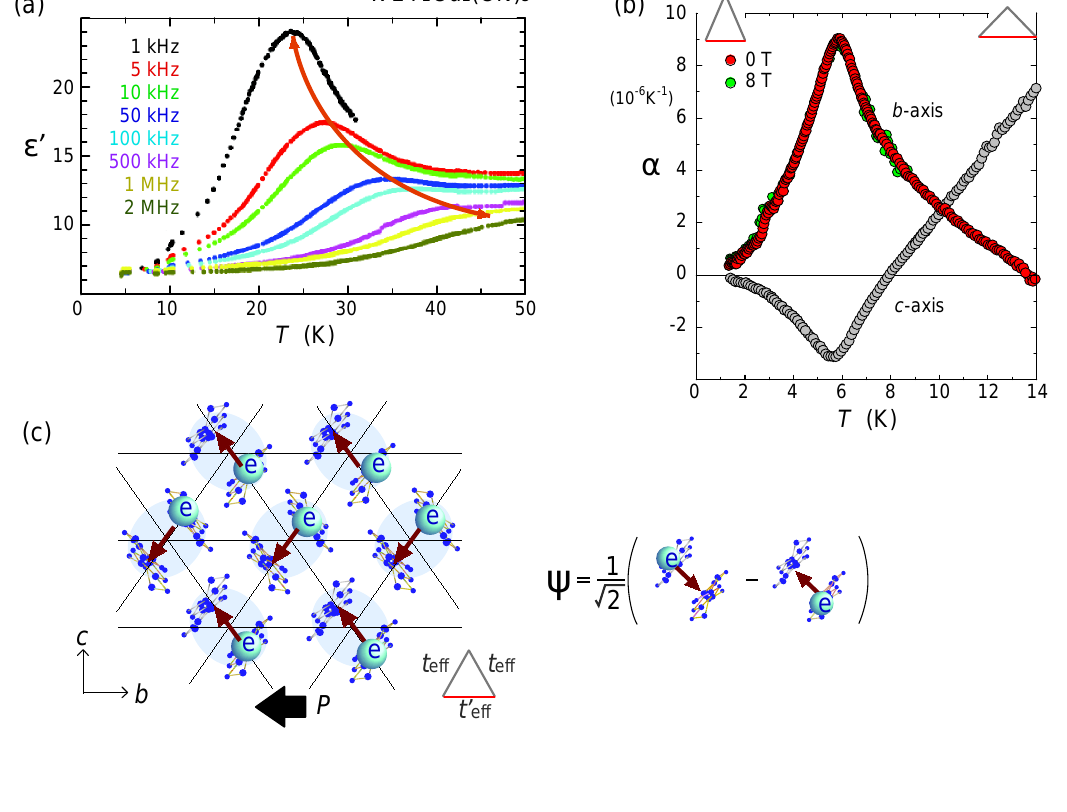
Figure 22. ( a ) Dielectric constant of a single crystal of κ -ET the courtesy of Ichiro Terasaki; ( b ) In-plane uniaxial expansion coefficients, α = ( dl/dT ) /l of κ -ET Cu (CN) by Mana et al ., adapted with permission from [102], copyrighted by 2 2 3 the American Physical